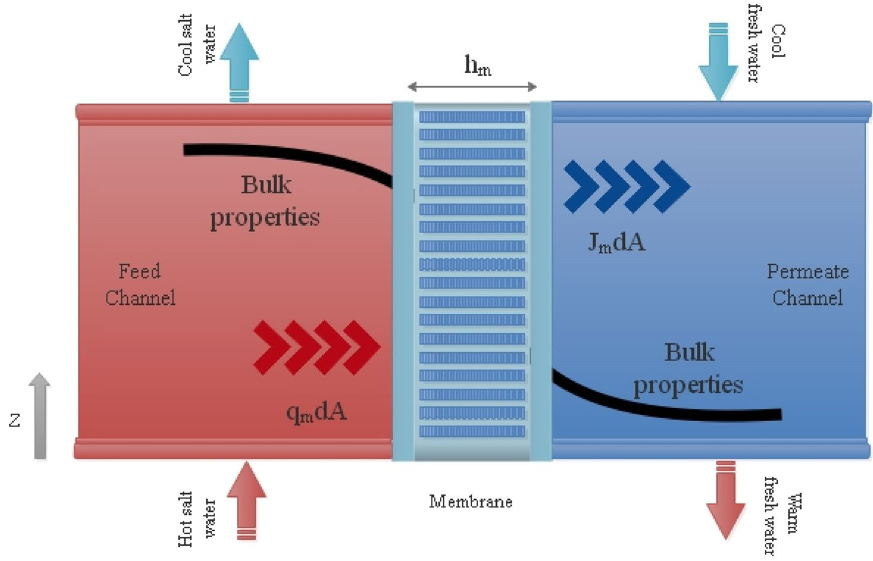
Figure 2. The schematic of control